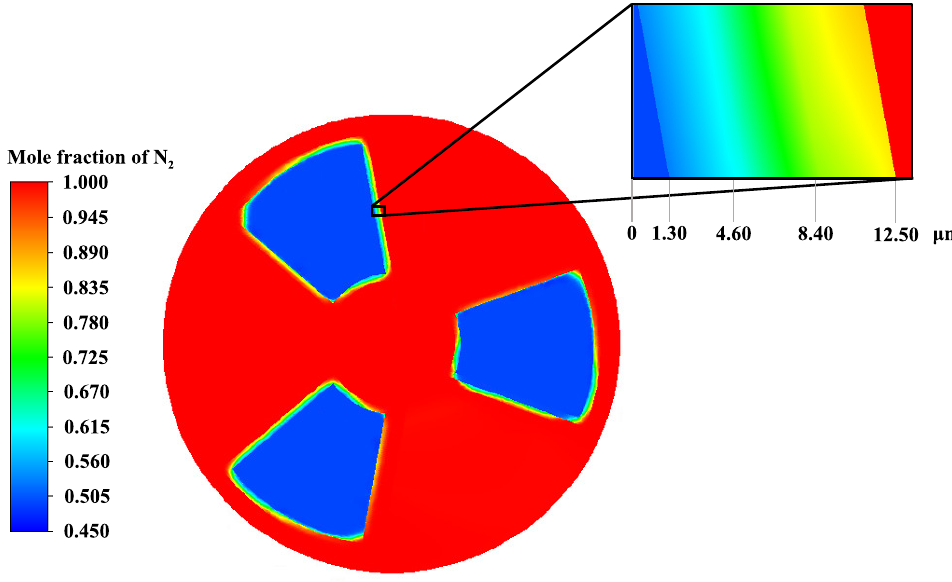
Figure 12. Concentration gradient of N 2 mole fraction for R4 illustrating the small length scales in micrometers for each contour along the reagent-purge boundary region, which limits the availability for studying the temporal progression of surface coverage as depicted in Figure